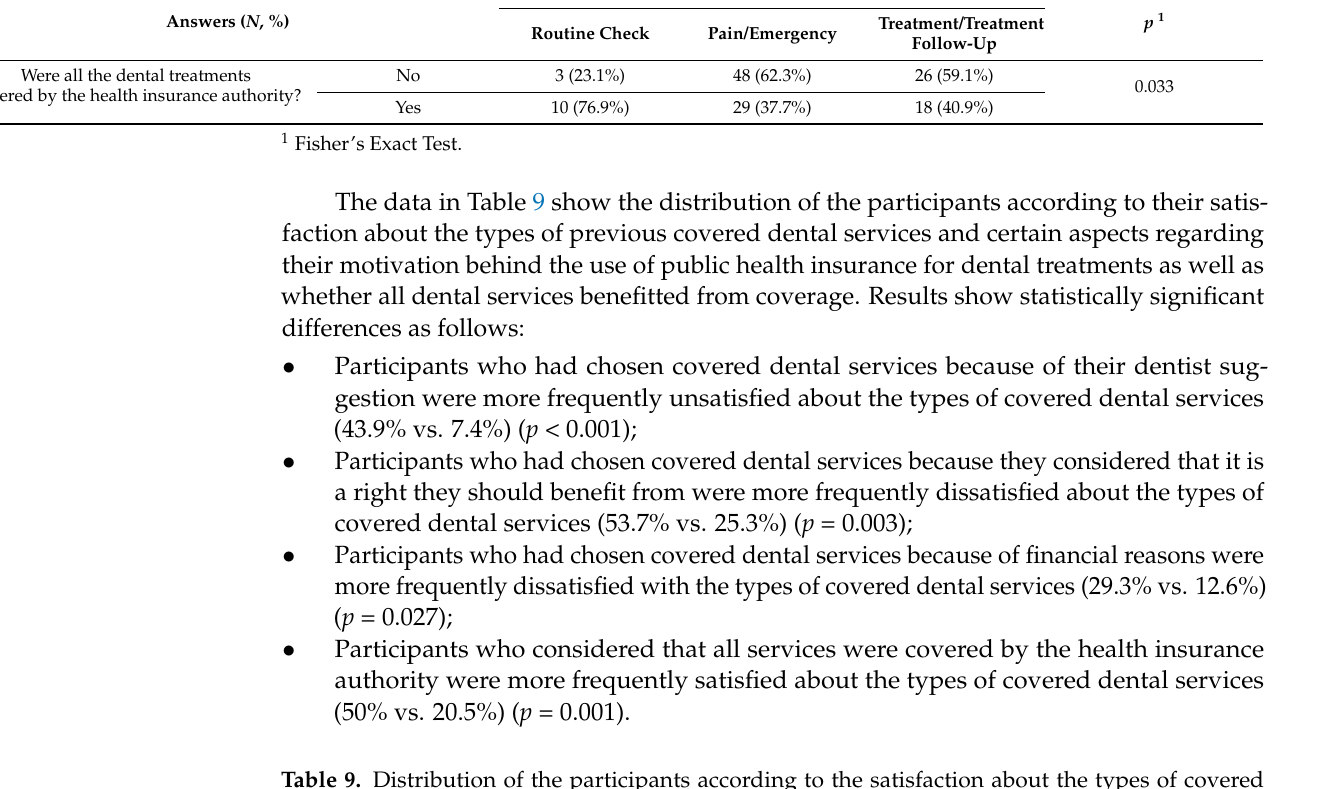
Table 9. Distribution of the participants according to the satisfaction about the types of covered dental services and certain answers in the